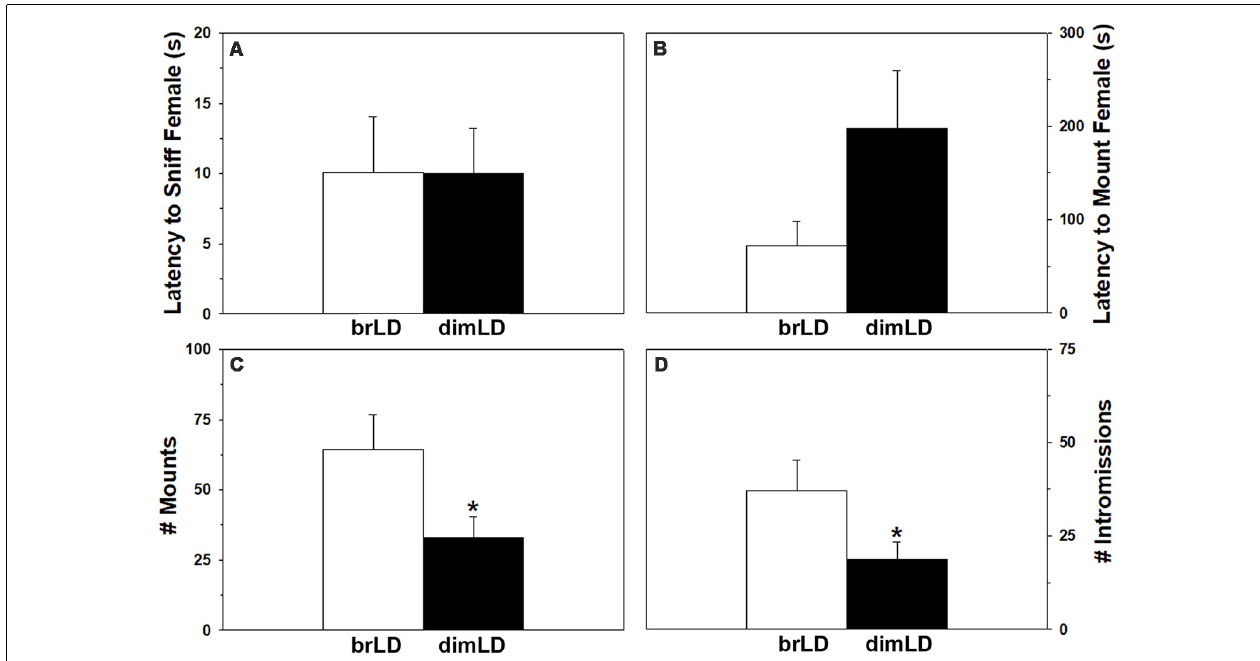
FIGURE 1 | Behavioral response to dim daylight. Male grass rats were housed in bright daylight intensity (brLD) or dim daylight intensity (dimLD) and their (A) latency to sniff an estrus female, (B) latency to mount an estrus female, (C) frequency of mounts, and (D) frequency of intromissions is shown (Means ± SEMs). ∗ p < 0.05.